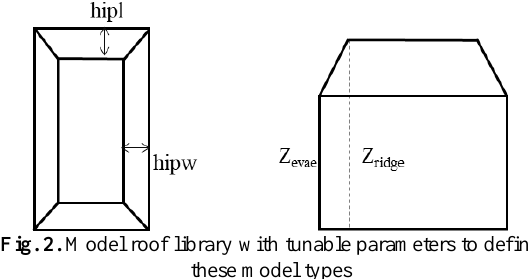
Fig. 2. Model roof library with tunable parameters to define